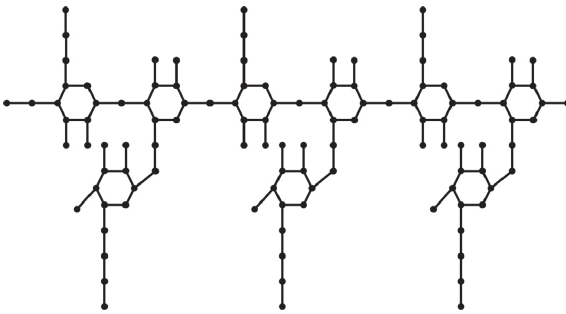
Figure 3: The molecular graph of HPG for n � 3.